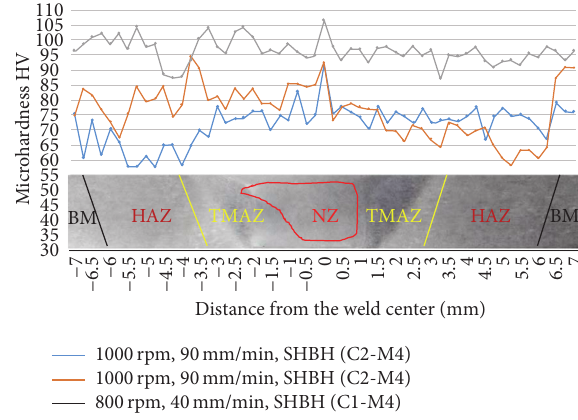
Figure 9: Vickers microhardness along the welding zone for the SHBH welded